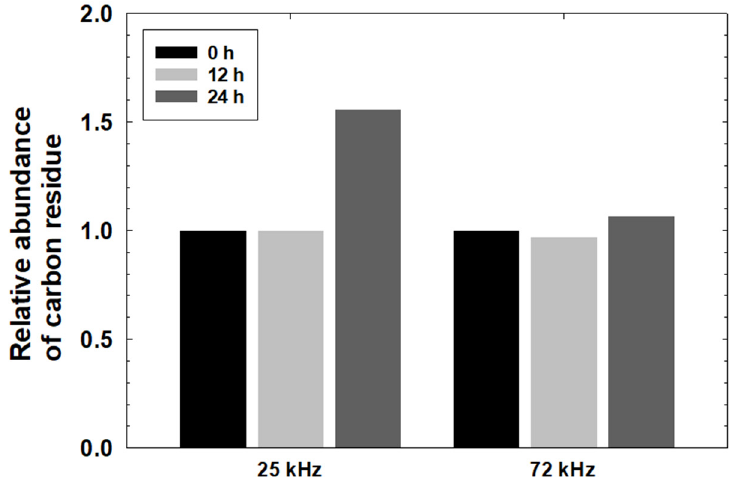
Figure 4. Variations in carbon residue for EBO2 at frequencies of 25 and 72 kHz.